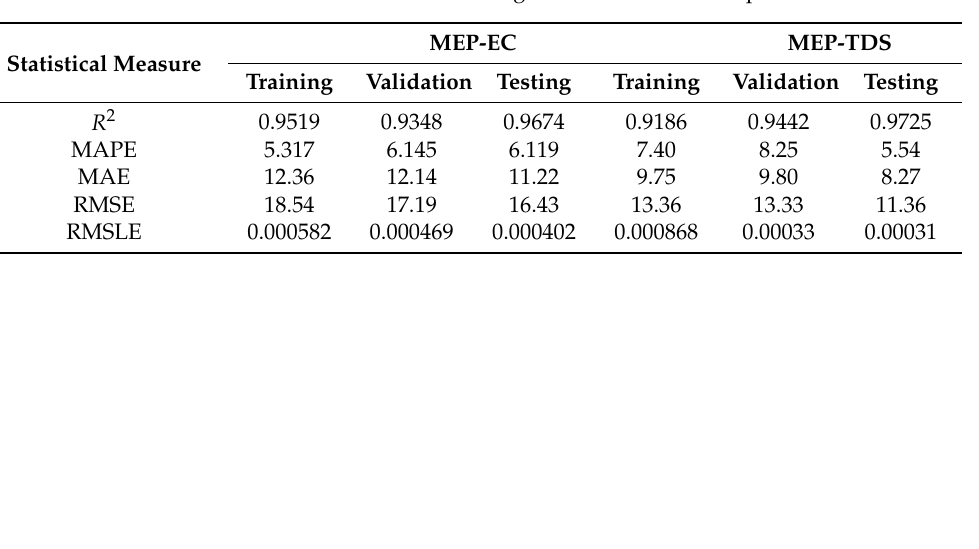
Table 5. Statistical error measurement of non-linear regression models developed for EC and